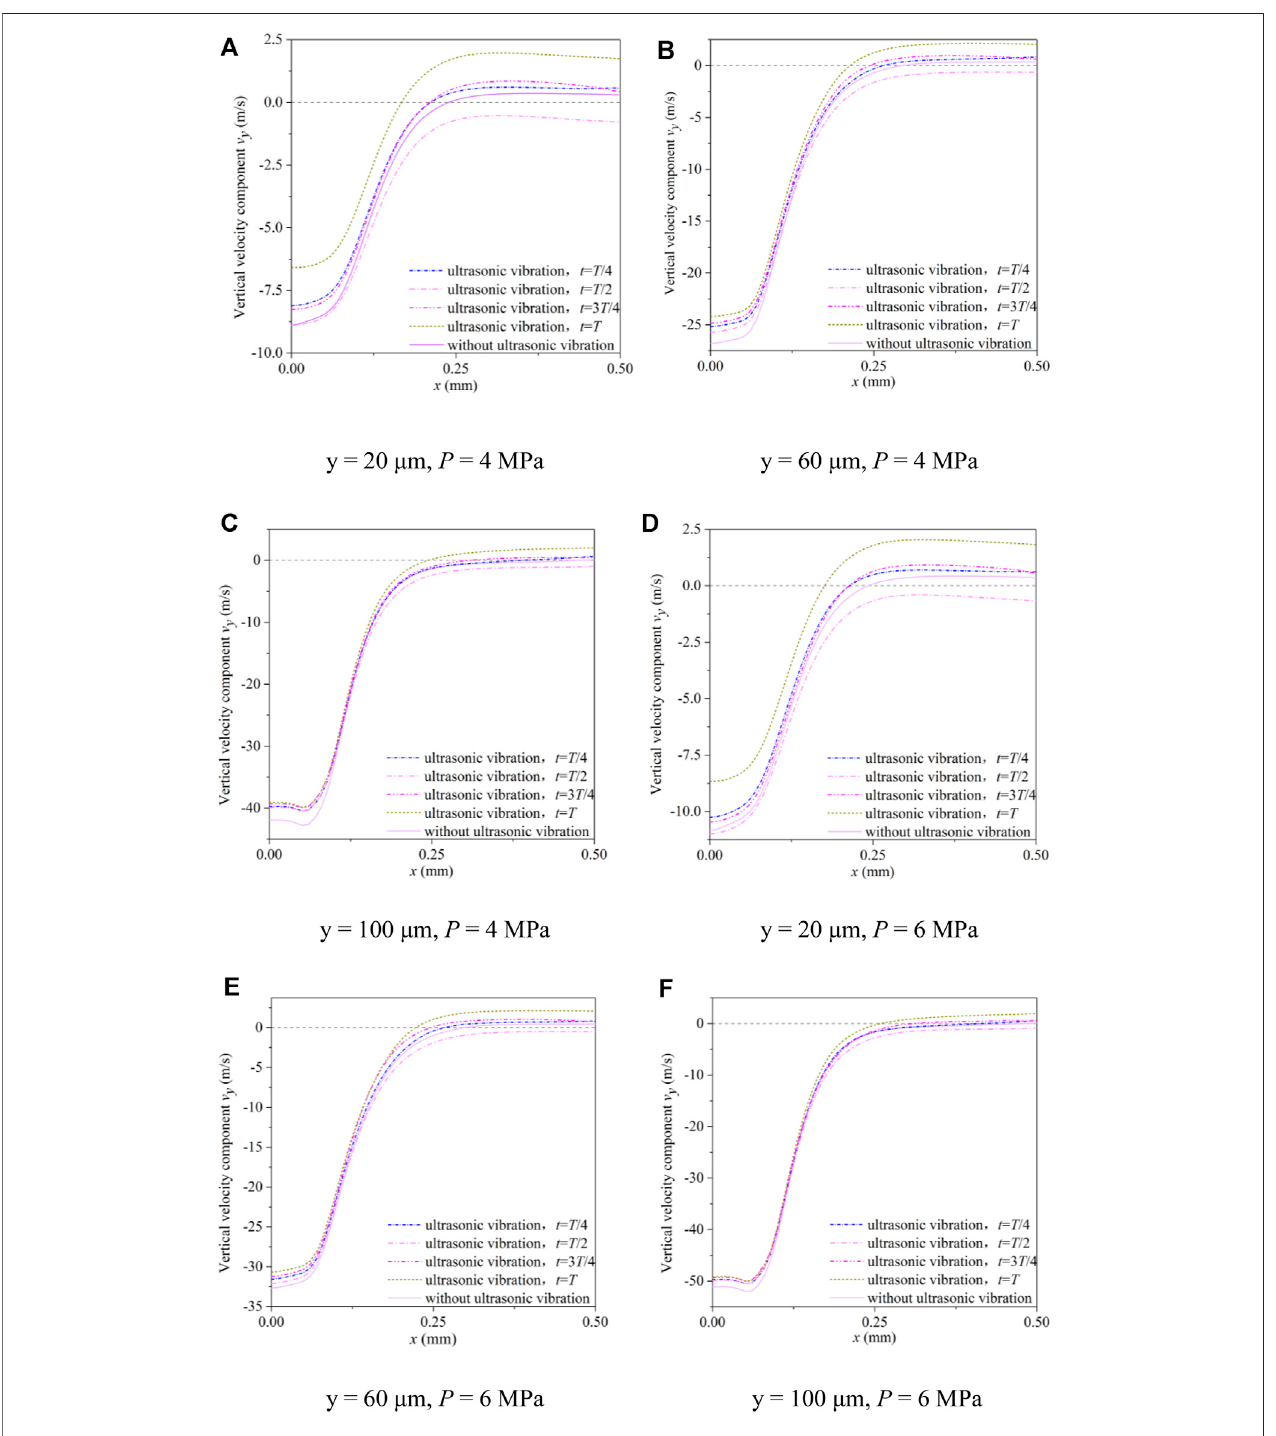
FIGURE5| Theverticalcomponentofthejetvelocitynearthesurfaceoftheworkpiece. (A) y =20 μ m, P =4 MPa, (B) y =60 μ m, P =4 MPa, (C) y =100 μ m, P =4 MPa, (D) y =20 μ m, P = 6 MPa, (E) y = 60 μ m, P =6 MPa, (F) y = 100 μ m, P =6 MPa, (G) y =20 μ m, P = 8 MPa, (H) y = 60 μ m, P =8 MPa, (I) y = 100 μ m, P =8 MPa.